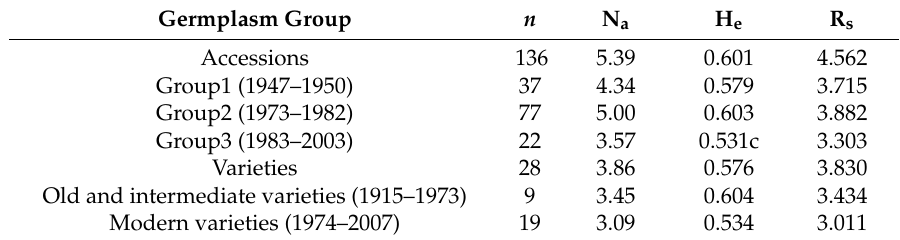
Table 1. Genetic diversity estimates for 136 ex situ accessions per collection year and 28 durum wheat varieties per year of release. Germplasm Group n N a H e R